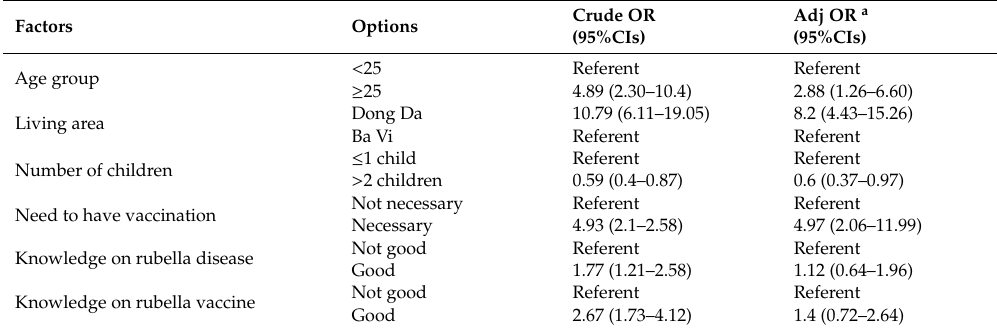
Table 4. Multivariable logistic regression analysis of factors associated with the utilization of the rubella